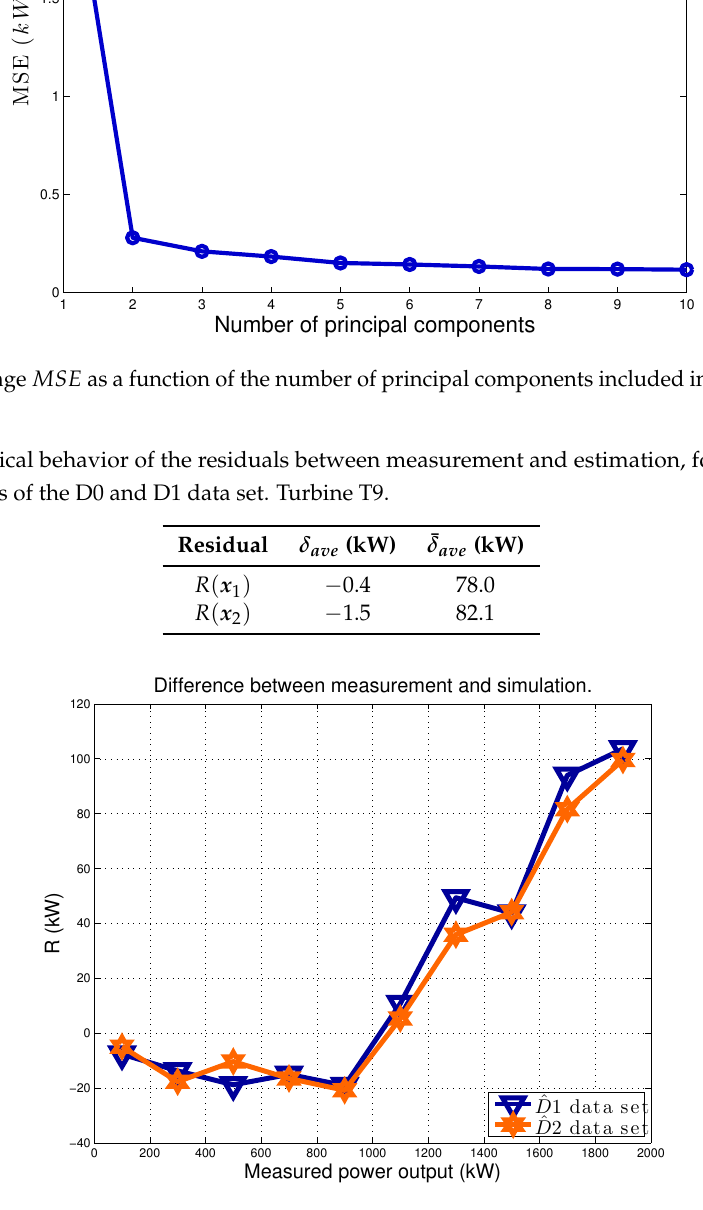
Figure 9. The average difference R between power measurement y and estimation ˆ y (Equation 8). Data sets: D1 and D2. Sample run of the model. Turbine T9